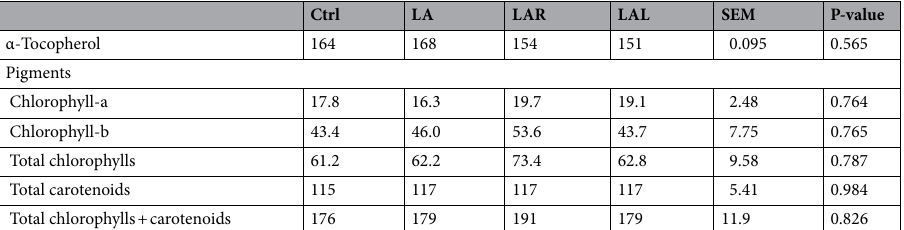
Table 3. Effect of dietary treatments on hepatic α-tocopherol (mg/100 g) and pigments (µg/100 g liver). Ctrl control diet, LA control + 10% Laminaria digitata , LAR LA + 0.005% Rovabio ® Excel AP, LAL LA + 0.01% alginate lyase, SEM standard error of the means. Values with different superscripts are significantly different at P < 0.05.